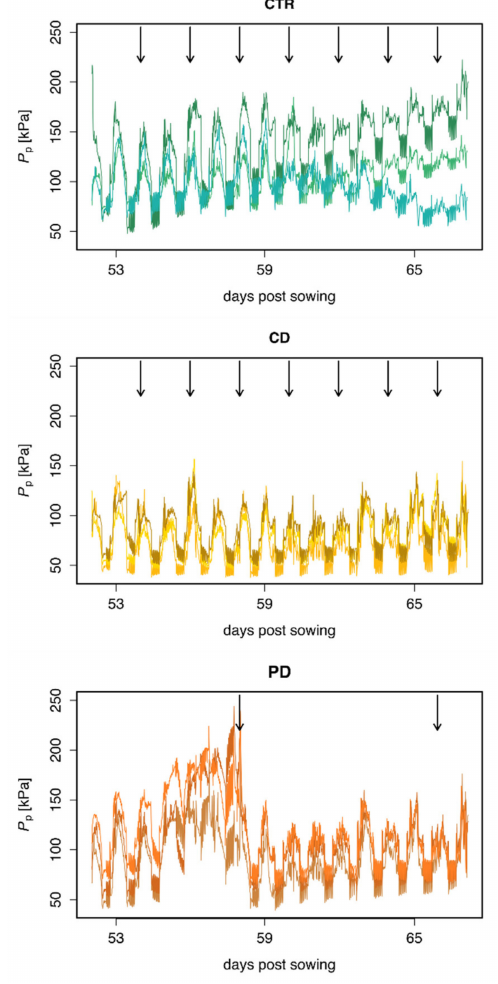
Figure 1. Continuous patch pressure ( P p ) recordings of flag leaves from non-mycorrhized wheat plants ( Triticum aestivum ) shown over time [days post sowing (dps)] recorded with ZIM-probes. Cultivation occurred under different irrigation conditions [control (CTR), continuous drought (CD) and pulsed drought (PD)]. Measurements started 52 dps (two days after last watering event for PD plants) and were recorded until 67 dps. Arrows indicate watering events (see Figure 8 for experimental set-up). Higher P p values indicate a lower turgor. During the measuring period, the pressure clamps were not